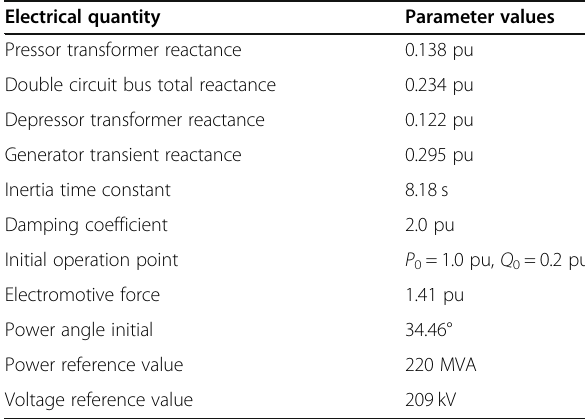
Table 1 Electrical parameters of the